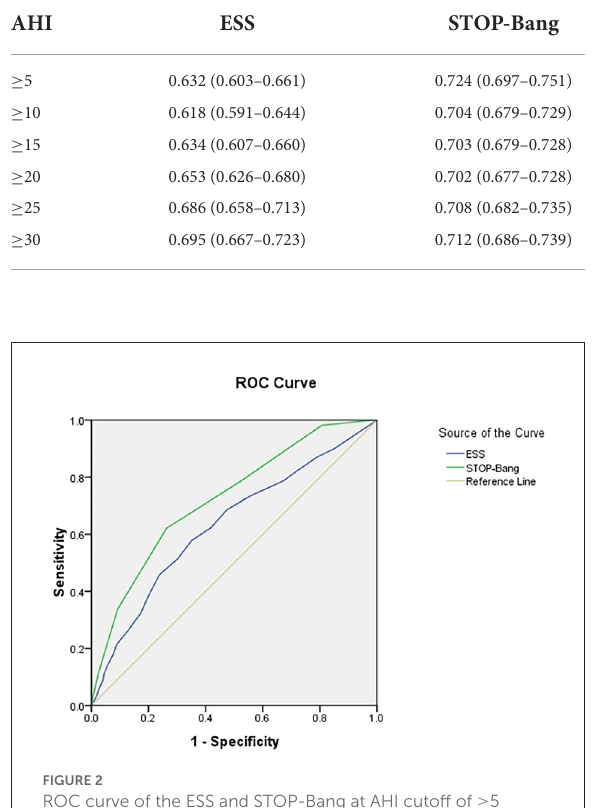
of BMI, neck circumference, waist circumference, AHI, ESS and STOP-Bang (Table 1).